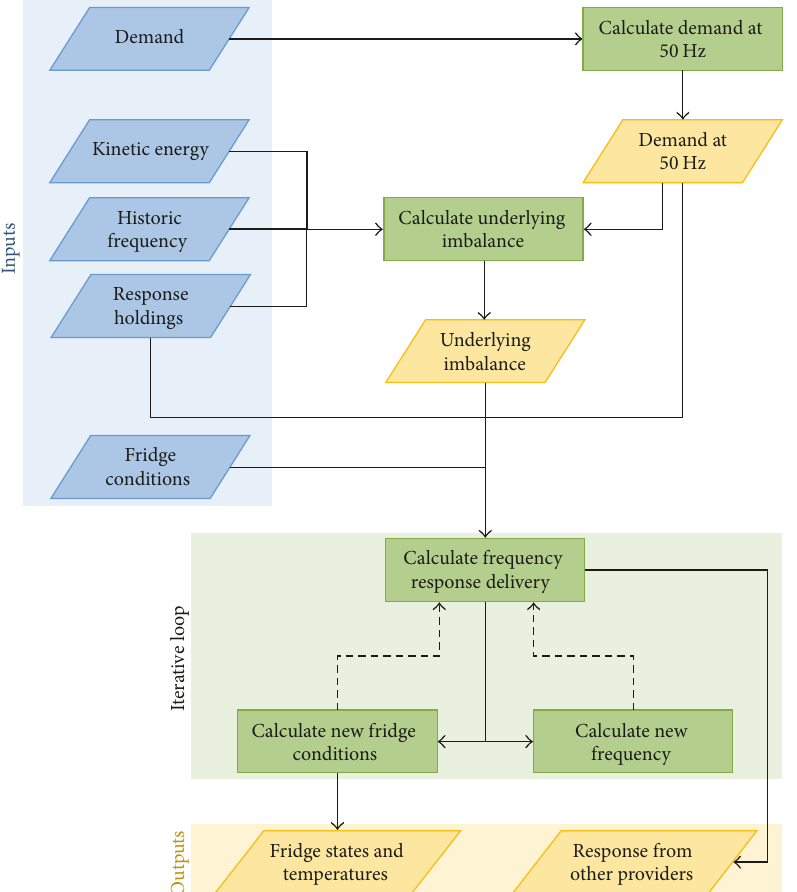
Figure 11: Simulation methodology diagram. Rhombi indicate input or calculated data/simulated data, and rectangles indicate meth- ods/calculations. Events occur from top to bottom with the exception of the dashed arrows which form the iterative